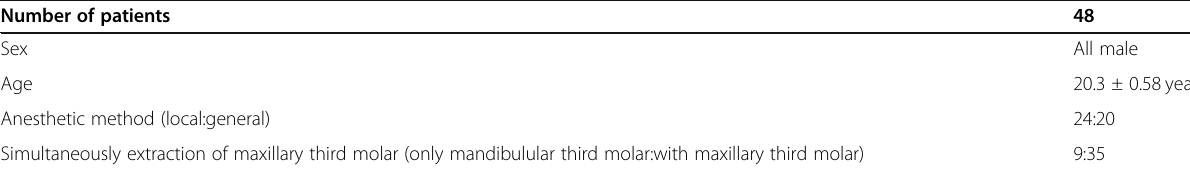
Table 1 Demographic and clinical information of the patients Number of patients